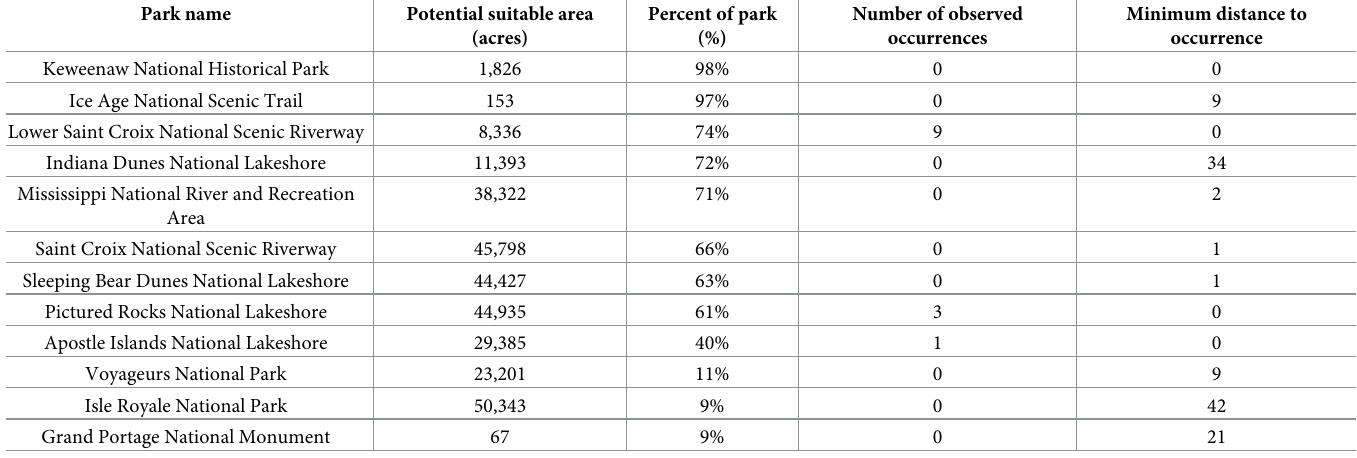
Table 3. Regional analysis table for bishop’s goutweed ( Aegopodium podagraria ) in Great Lakes EPMT unit including the potential suitable area for the one percen- tile threshold, percent of park is the percent of the park area that is classified as potentially suitable, number of observed occurrences indicates if presence locations from the park were available for model development, and minimum distance to occurrence is the minimum distance from the park boundary to a known occurrence used in model